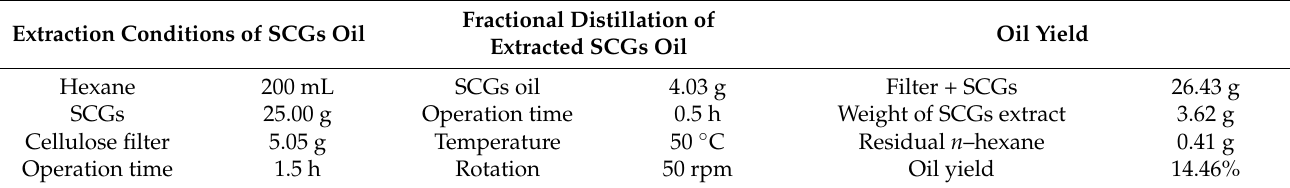
Table 1. Conditions of spent coffee grounds oil and